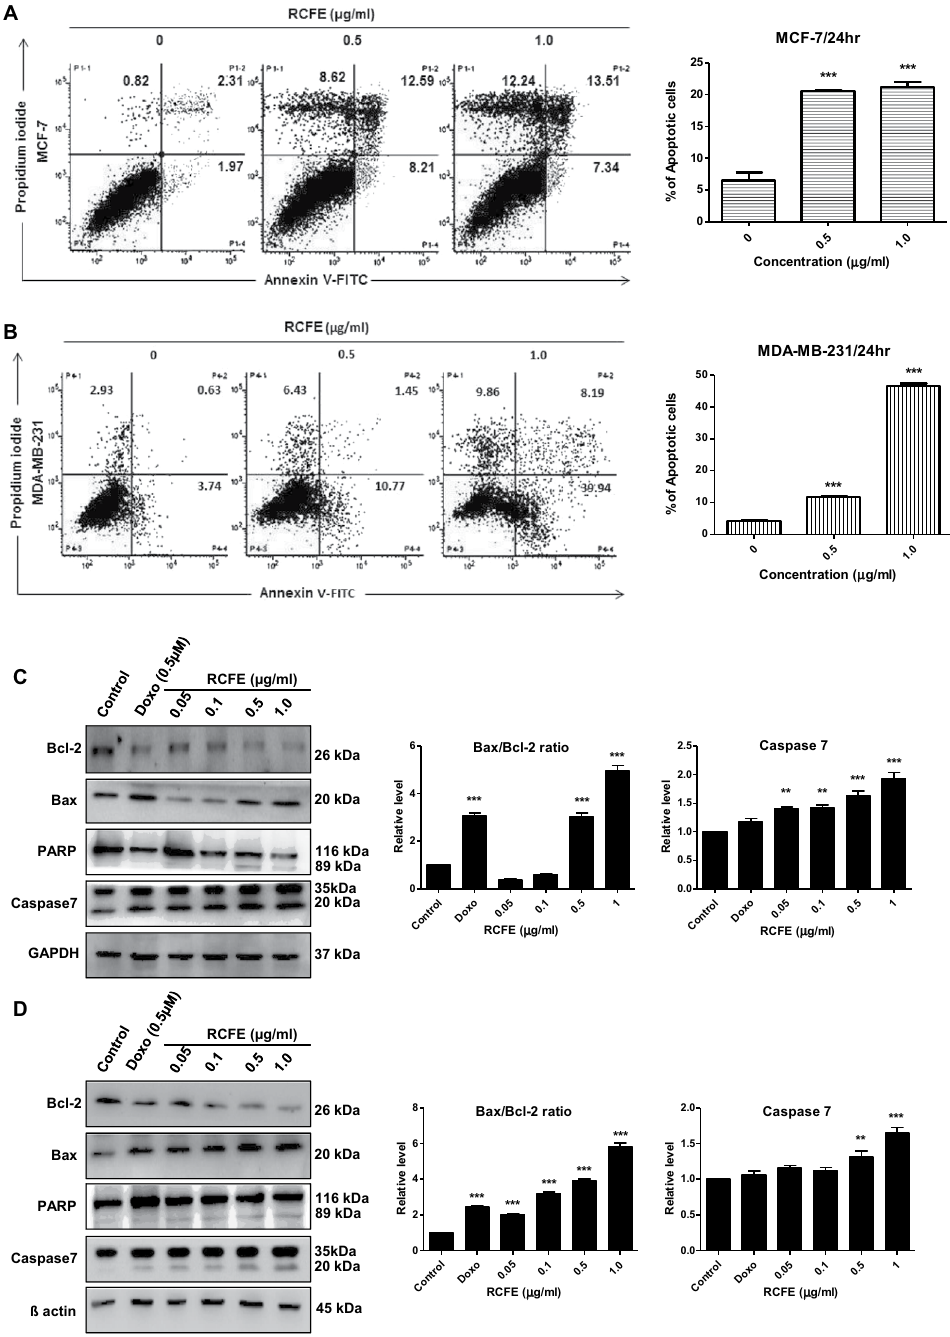
Figure 3. Induction of apoptosis by RCFE. Flow cytometer analysis of MCF-7 ( A ) and MDA-MB-231 ( B ) using Annexin V/PI. The quantitation of three independent analysis was presented in right panels. Western blot analysis of lysates from MCF-7 ( C ) and MDA-MB-231 ( D ) with antibodies against Bcl-2, Bax, PARP and Caspase-7. The ratio of Bax/Bcl-2 and caspase-7 expressions were normalized either to GAPDH or β -actin presented in the right panels. Doxorubicin (Doxo) was used as positive control. Statistical differences were analyzed with one-way ANOVA test. p value < 0.05 was considered